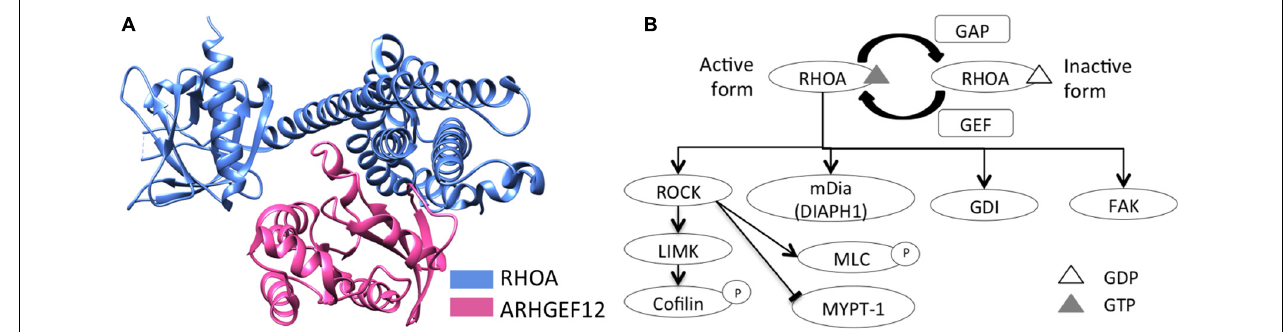
FIGURE 1 | RHOA schematic structure and its downstream signaling. (A) Schematic structure of RHOA and a GEF protein, LARG (ARHGEF12), were represented (RCSB PDB ID: 1X86). (B) RHOA downstream signaling was represented, regarding actin reorganization, cell motility, and cell migration.